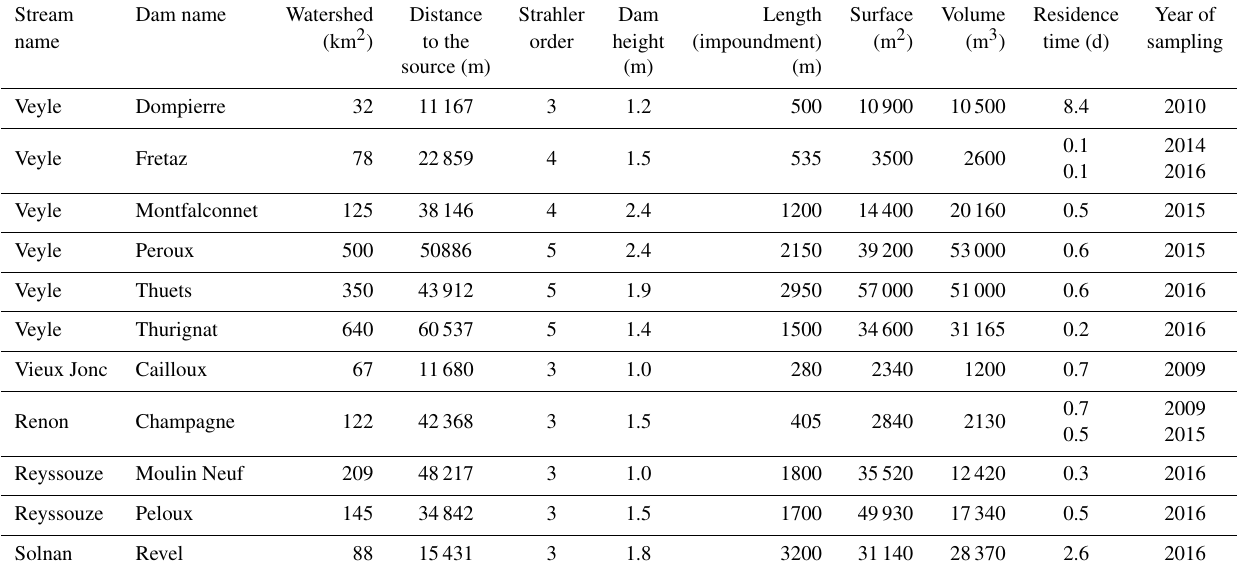
Table 1. Physical characteristics of dams of the river and impoundments. Stream